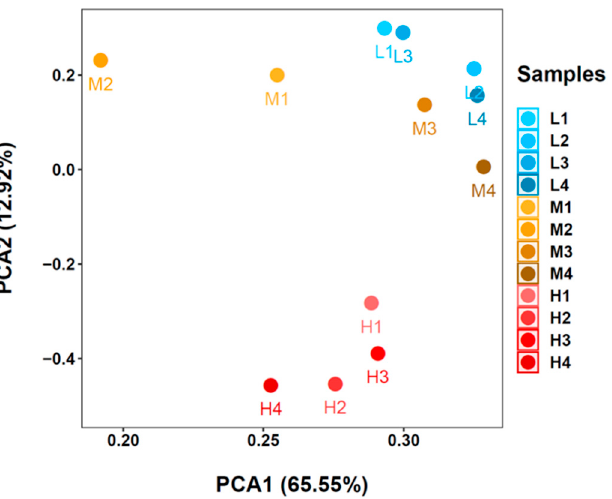
Figure 7. Principal coordinate analysis (PCA) on the composition of microbial communities at operational taxonomic units (OTU) level.